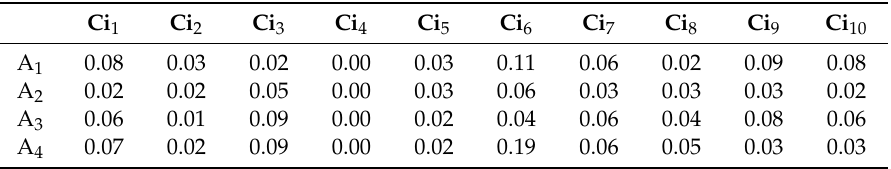
Table 26. The normalized weighted values of judgments matrix using the multi-objective optimization based on simple ratio analysis